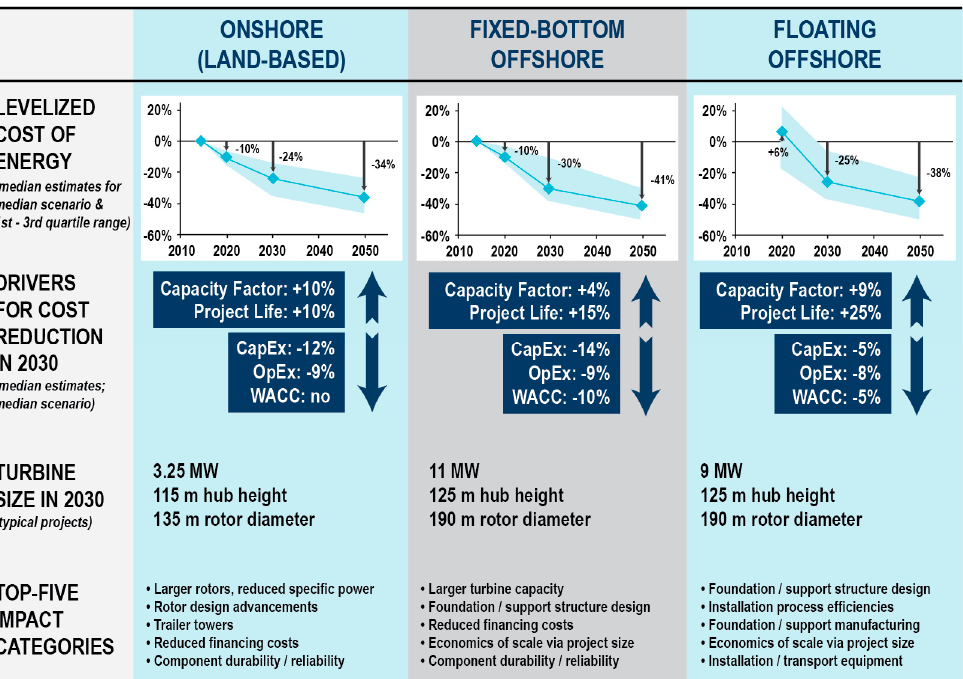
Figure 2. Summary of projected LCOE reductions for onshore wind, fixed-bottom offshore wind, and floating offshore wind installations for the period 2020–2050. Adapted from [26]. CapEx = Capital Expenditures, OpEx = Operational Expenditures, and WACC = Weighted Average Cost of Capital.